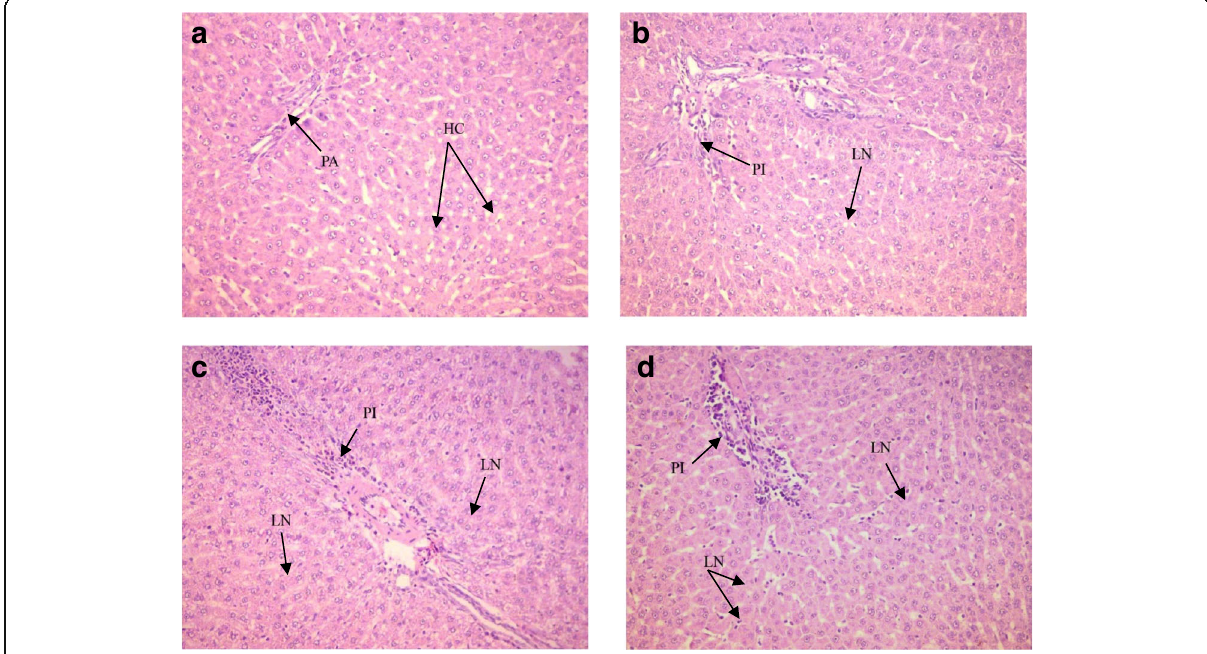
Fig. 2 Histopathological changes of liver tissues stained with Hemotoxylin and Eosin (HE) for 60 days (X200); ( N = 3/group). a Control, normal liver tissue with no abnormalities portal area (PA), and hepatocytes (HC). b 0.5 ppm NaF, inflammatory cells in the portal triads (PI) at moderate level and lytic necrotic (LN) hepatocytes. c 5 ppm NaF, inflammatory cells in the portal triads (PI) at moderate levels, and widespread necrosis (LN). d 20 ppm NaF, inflammatory cells in the portal triads (PI) at moderate levels, and multifocal lytic necrosis